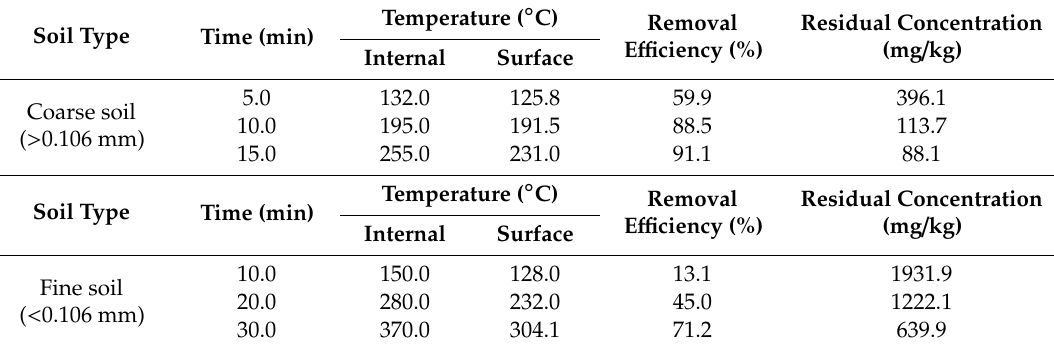
Table 5. Removal e ffi ciency and temperature as a function of time for di ff erent particle